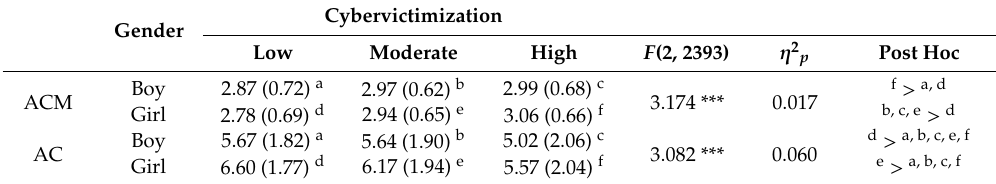
Table 5. Means, standard deviations (SD), and ANOVA results between cybervictimization, gender, avoidant communication with mother, and academic competence.